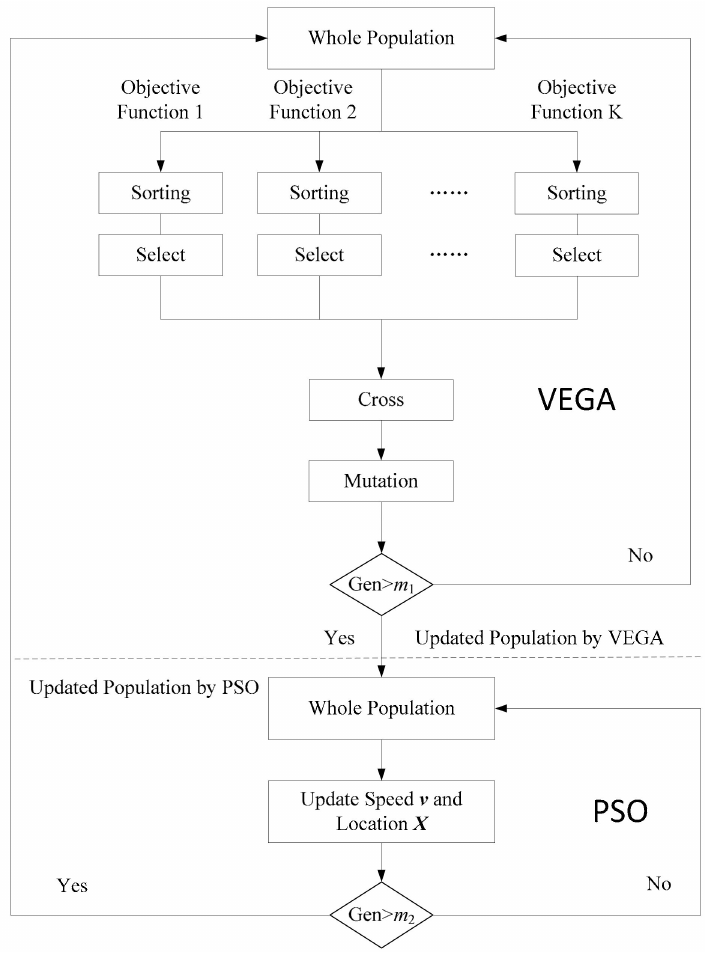
Figure 2. Flowchart of an entire optimizing cycle of the hybrid VEGA–PSO